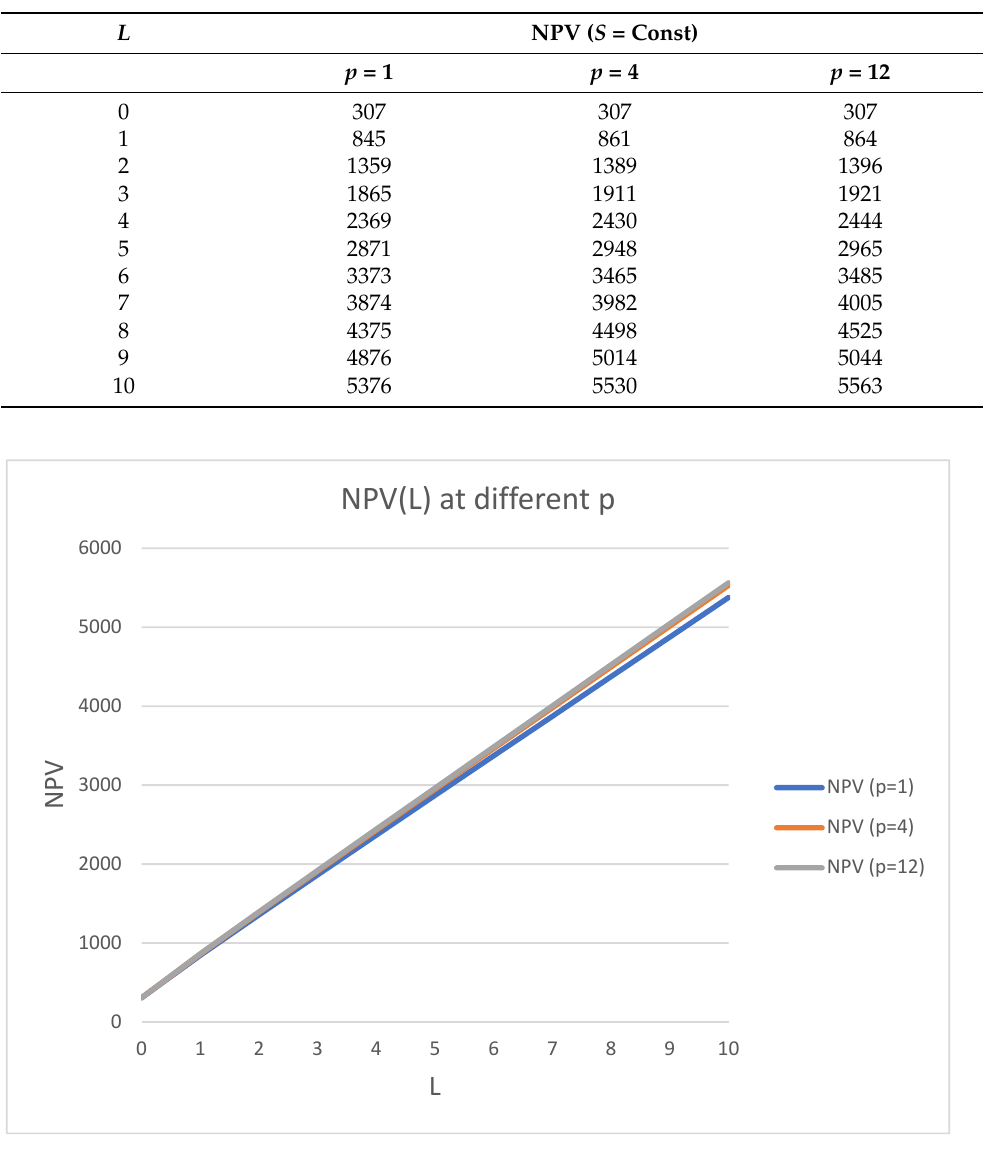
Figure 11. Change of net present value, NPV, with leverage, L , for k d = 0.14; k 0 = 0.22; p = 1, 4, and 12; and n = 3 (larger scale).